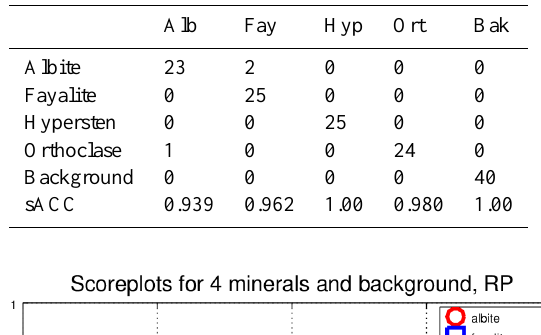
Figure 9. Score plot using the two first PCA components from RP projection of full spectra. The region shown is zooming into the cluster at far right in Fig.